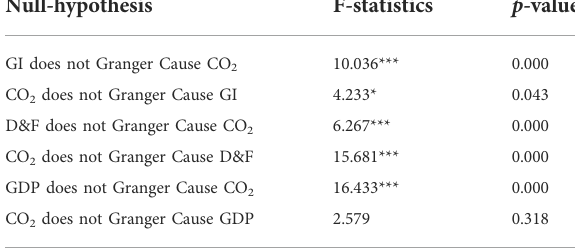
TABLE 7 Granger causality